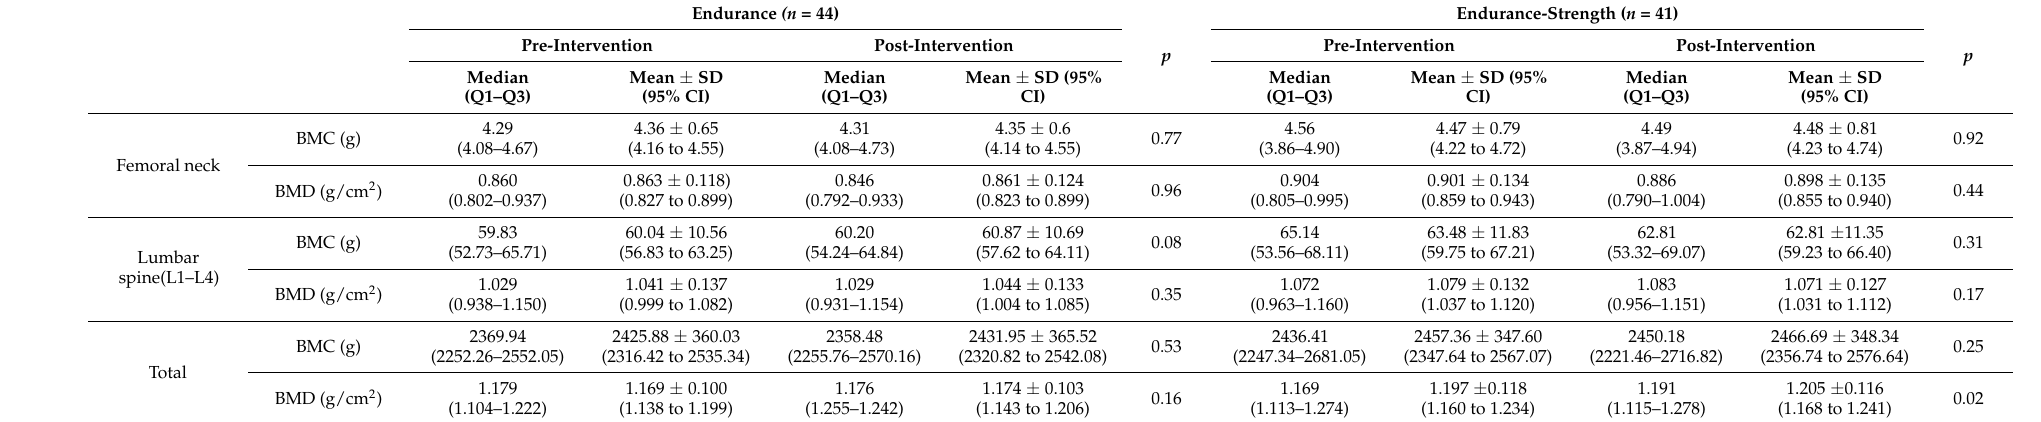
Table 3. The effect of endurance ( n = 44) and endurance-strength training ( n = 41) on densitometric parameters.